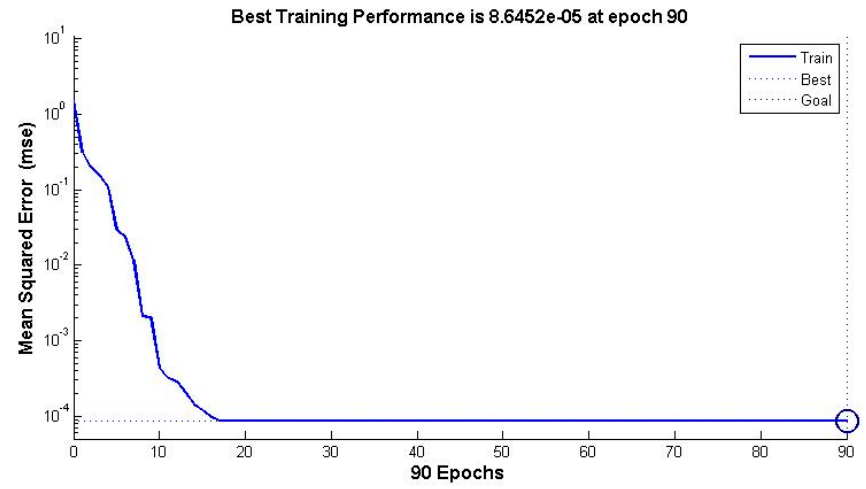
Figure 10. The training process of GA-BPNN.